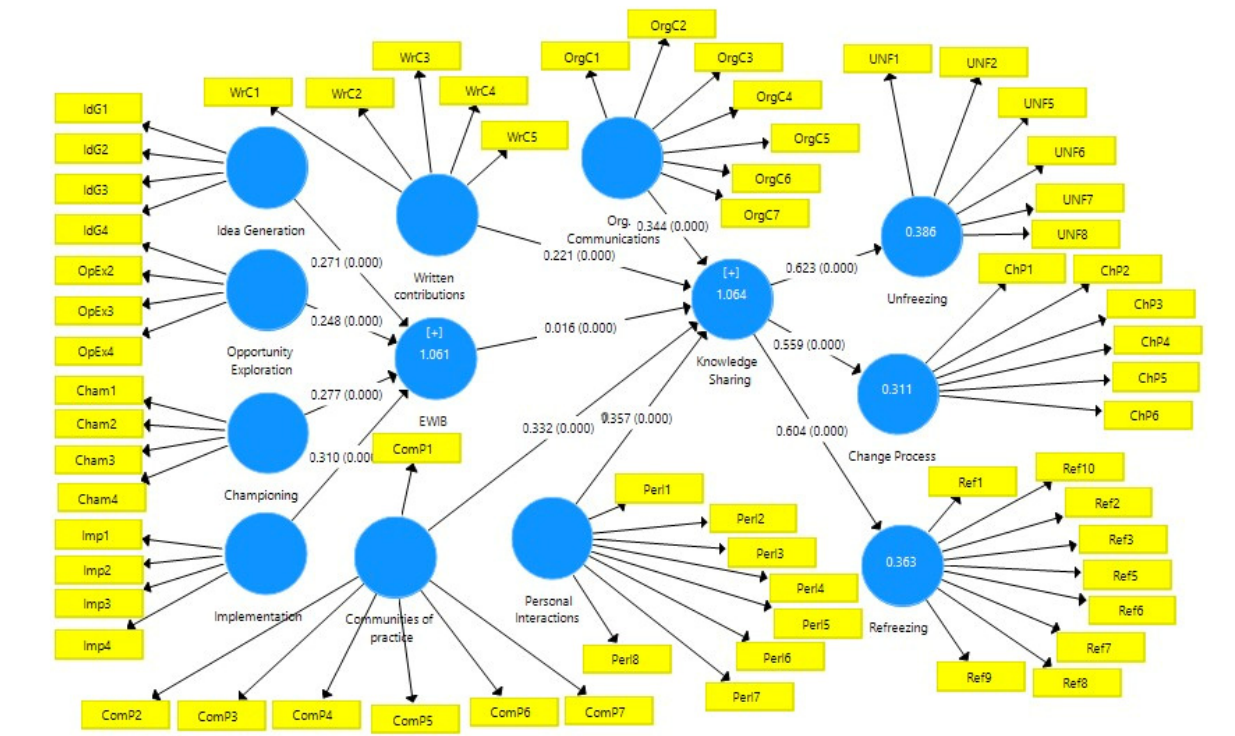
Figure 2. Structural model.